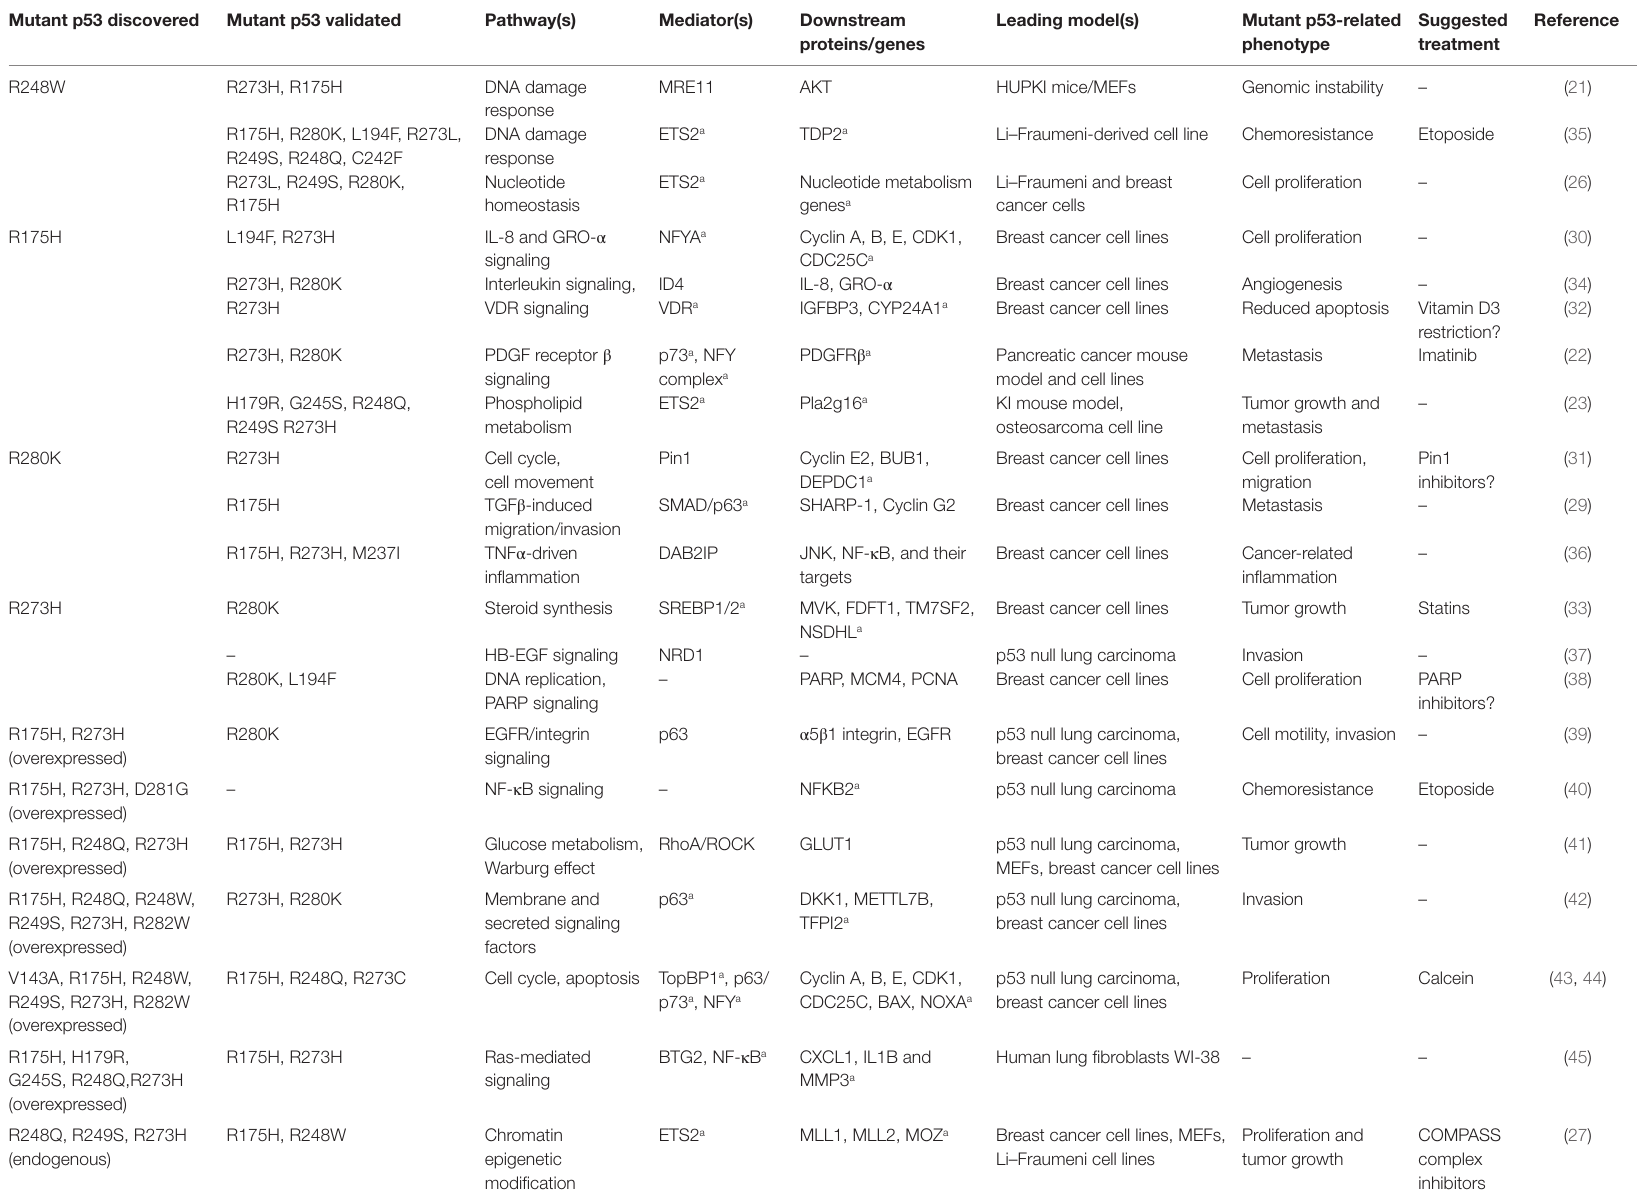
TABLe 1 | Selected mutant p53 gain-of-function effects, mediators, and related therapeutic opportunities, published since 2005. Mutant p53